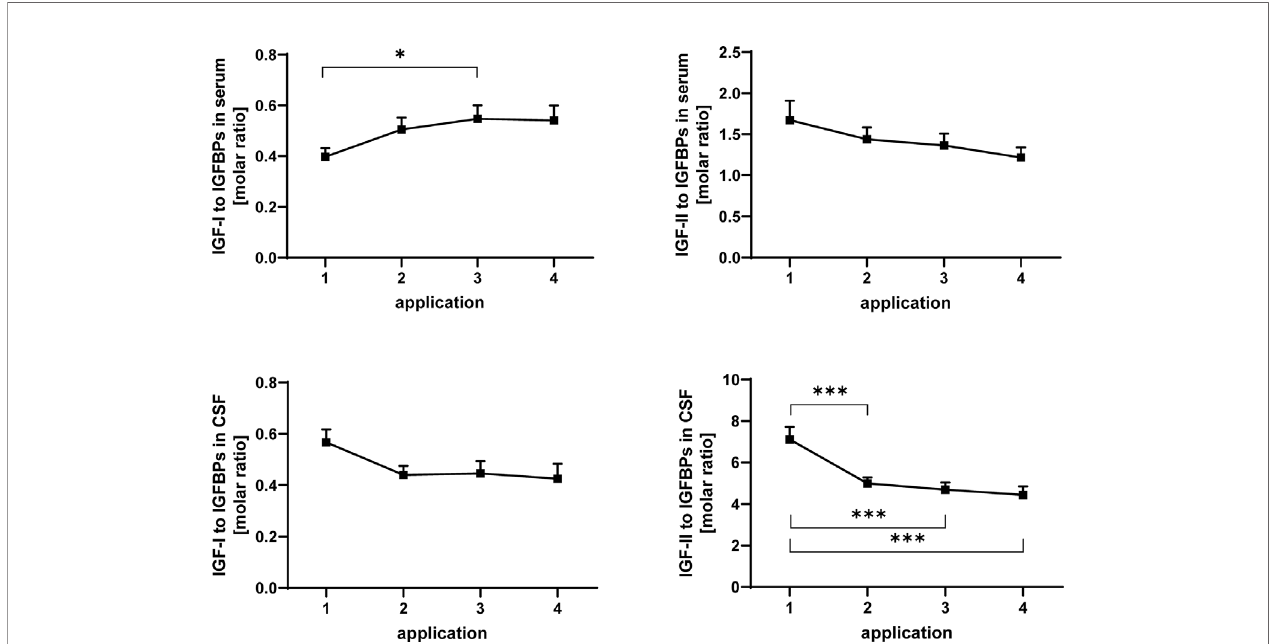
FIGURE 6 | Molar ratios of IGF-I (left panels) and IGF-II (right panels) in serum (upper panels) and CSF (lower panels) to total IGF-binding activity detected by Western ligand blotting. The samples were obtained from MS patients with spasticity receiving treatment cycles of four intrathecal TCA applications. Total IGFBP activity is composed of IGFBP-2 and IGFBP-3. The plot depicts the average change in molar ratios over 20 treatment cycles (14 cycles in four males and 6 cycles in two females). Data are given as means ± SEM (*p < 0.05; ***p <